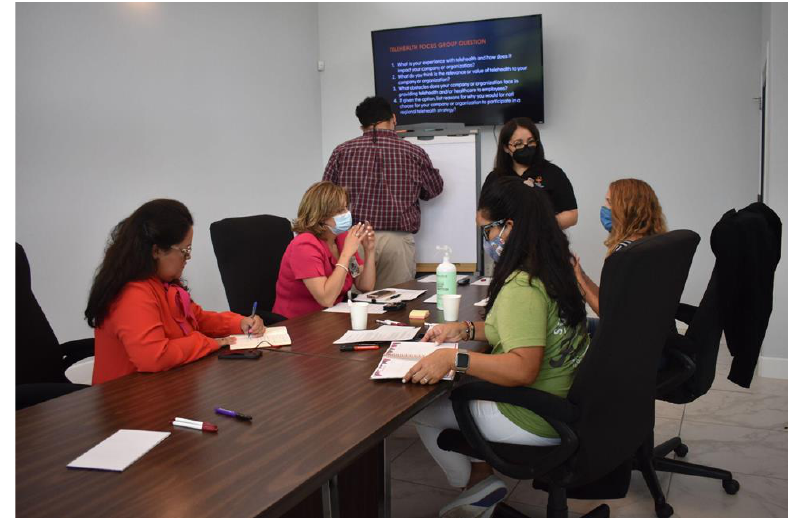
Figure 5. Photo of community partners focus group.